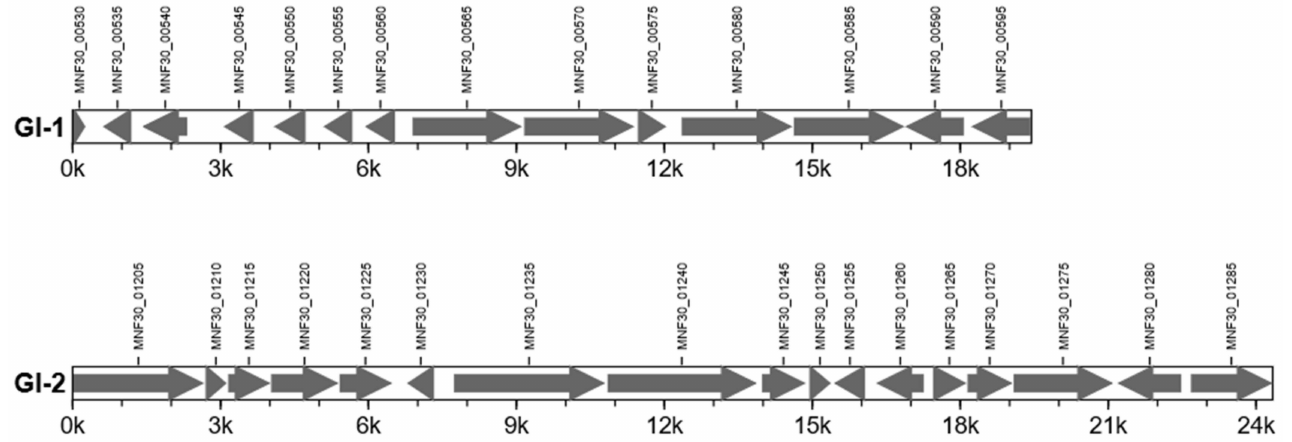
Figure 4. Gene distribution map in the Mmc HN-A gene island. Note: The abscissa is the length